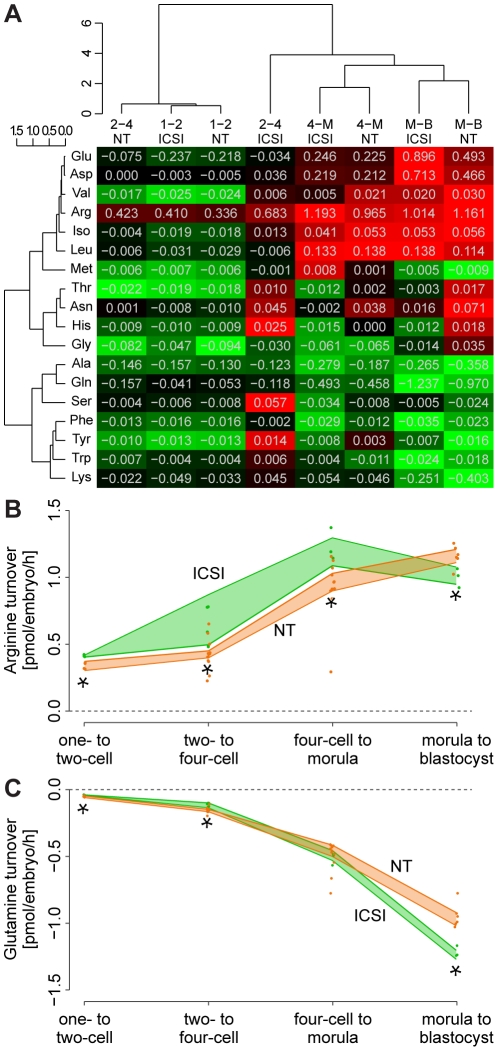
Analysis of amino acids in culture media of NT and ICSI pre-implantation embryos.A) Amino acid turnover profile of NT and ICSI embryos at 0–24, 24–48, 48–72 and 72–96 hours post activation, hpa, respective one-/two-cell (1–2), two-/four-cell (2–4), four-cell/morula (4–M) and morula/blastocyst (M–B) stages and unsupervised hierarchical clustering. Red, consumption; green, release into the culture medium; black, low turnover. At two-/four-cell stage, NT embryos cluster with earlier stages while ICSI cluster with later developmental stages, suggesting that NT embryos undergo the amino acid metabolic switch later than ICSI. Cell values indicate amino acid depletion/appearance in pmol·embryo−1·h−1. B) Arginine and C) glutamine turnover profile of ICSI and NT embryos over time. Arginine is depleted from the medium while glutamine is released; *, turnover significantly different between NT and ICSI (t test, p<0.05). Consumption of arginine by NT embryos is lower than by controls until morula stage.